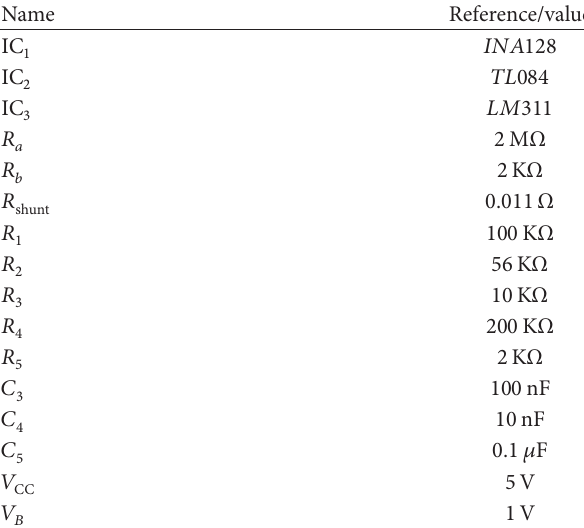
Table 4: Integrated circuit specifications and parameter values of the